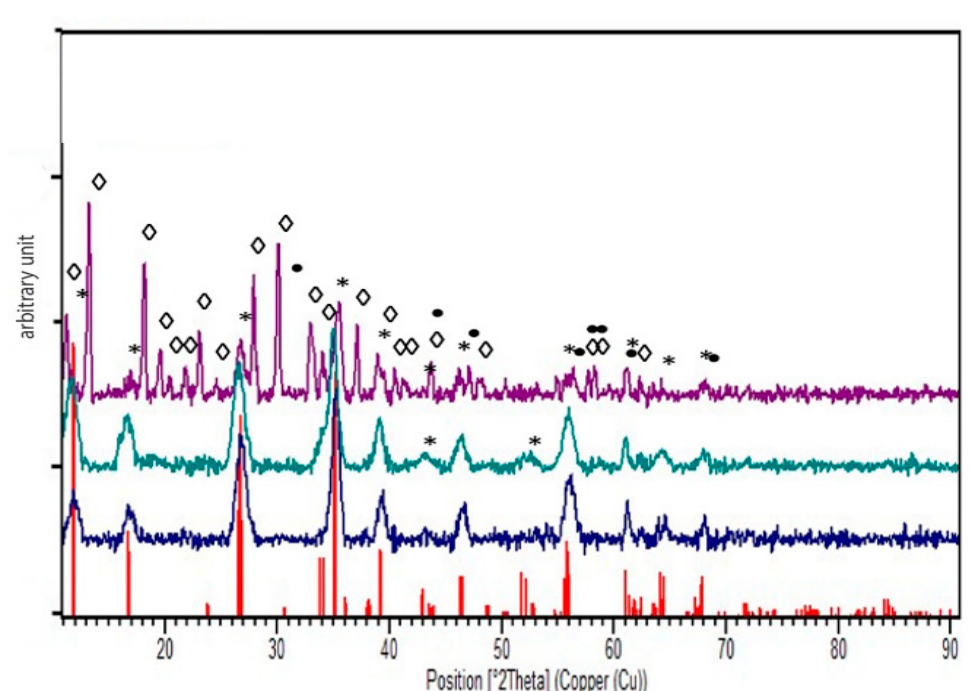
Figure 3. XRD diffractograms of NBS cultures media measured under agitation (purple, top), stationary (teal, middle), and abiotic control (navy, bottom) and compared to the akaganeite reflections from the ISCD database indicated in red. Akaganeite is indicated with [ * ], vivianite is indicated with [ ♦ ], and Iron Sulphide is indicated with [ •].